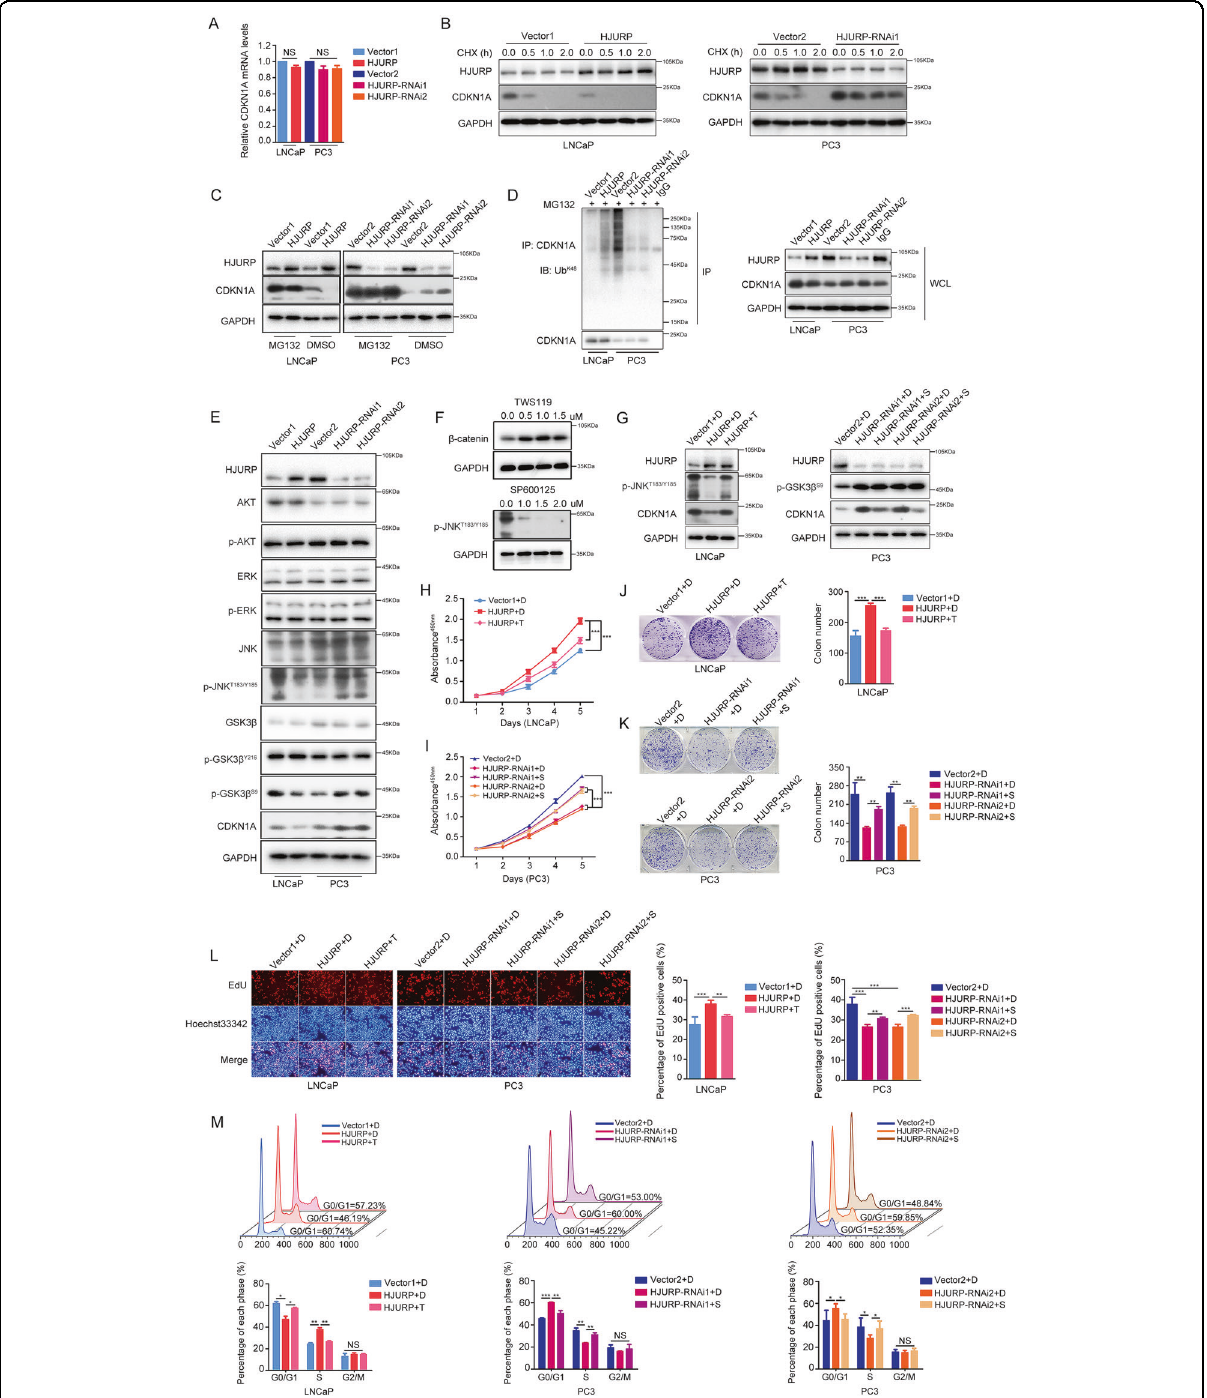
Fig. 5 HJURP promotes CDKN1A ubiquitin-dependent proteasomal degradation through the GSK3 β /JNK pathway. A qPCR quanti fi cation of CDKN1A mRNA levels in PCa cells after HJURP -overexpression or -silencing. B CHX (50µg/mL) was used to treat LNCaP and PC3 cells for 0, 0.5, 1.0, and 2.0h, and western blotting was applied to quantify CDKN1A stability. C MG132 (10µM) was employed to incubate cells for 6 h, and western blotting was utilized to quantify CDKN1A levels after HJURP -overexpression or -knockdown in PCa cells. D CO-IP quanti fi cation of the effects of HJURP on CDKN1A ubiquitination. E Western blotting of AKT , p-AKT , ERK1/2, p-ERK1/2 , JNK , p-JNK T183/Y185 , GSK3 β , p-GSK3 β Y216 , p-GSK3 β S9 , and CDKN1A levels in PCa cells after HJURP -overexpression or -silencing. F Western blotting quanti fi ed optimal TWS119 and SP600125 concentrations (0.5 µM TWS119 and 1.0µM SP600125 were selected). G TWS119 could reverse HJURP -induced reduction in p-JNK T183/Y185 and CDKN1A , whereas SP600125 could reverse HJURP - induced CDKN1A elevation, but did not affect p-GSK3 β S9 levels. H – M TWS119 and SP600125 could reverse HJURP -induced changes in cell viability ( H ), clonogenic potential ( J ), proliferative capacity ( L ), and cell cycle ( M ) in PCa cells. CHX cycloheximide, DMSO dimethyl sulfoxide, Ub